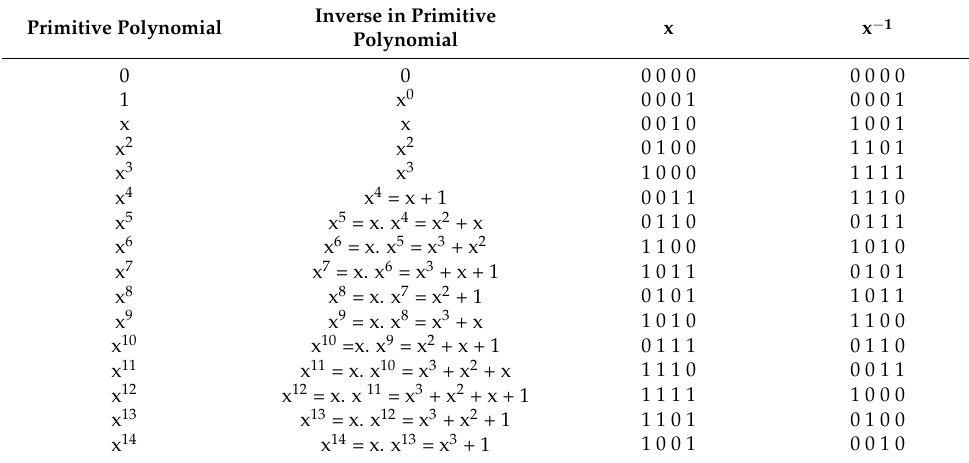
Table 3. Inversion table computation over GF(2 4 ).